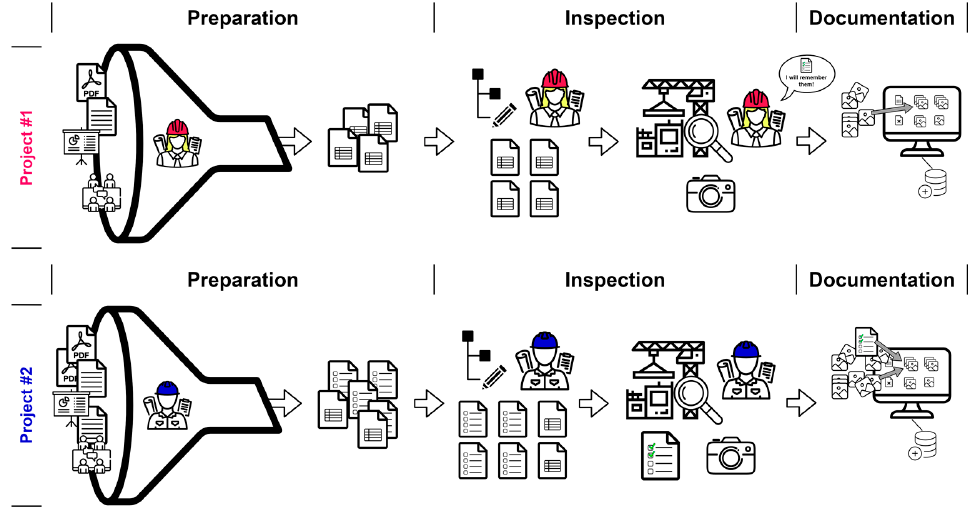
Figure 1. Two examples of project-based variation within construction sites’ quality control pro- cesses.